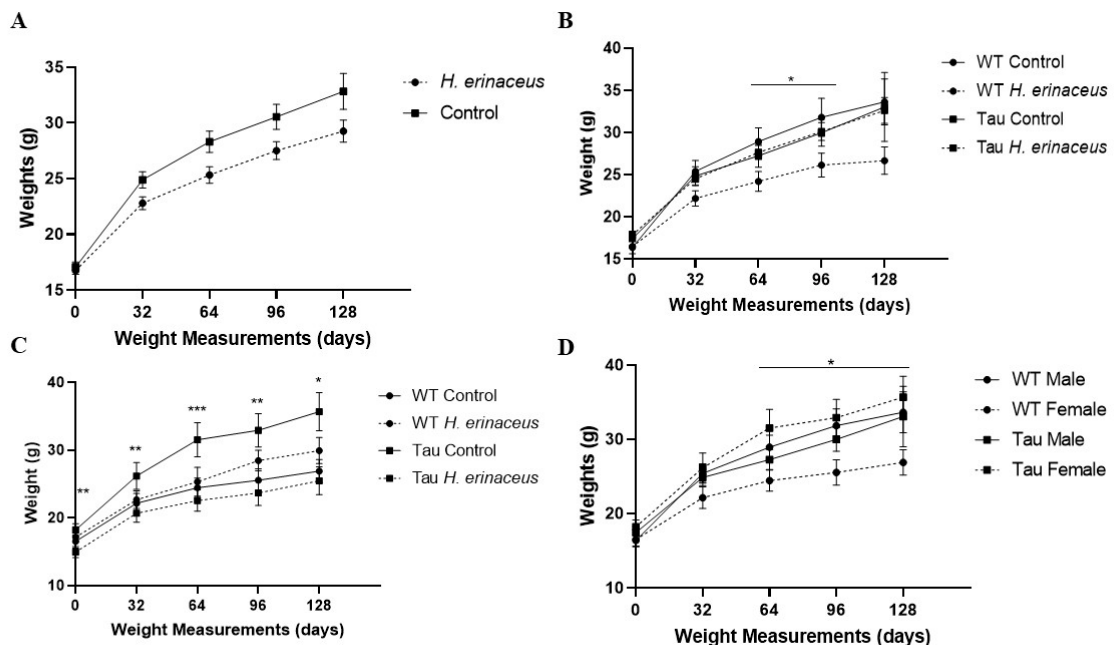
Figure 1. Weights over time. ( A ) Mice on the control diet (no H. erinaceus ) weighed significantly more than those given H. erinaceus . ( B ) Male WT mice given the control diet weighed significantly more than their H. erinaceus counterparts at 64 days and 96 days; only male mice are graphed. ( C ) Female tau mice on the control diet weighed significantly more at each weighing point than female tau mice given H. erinaceus ; only female mice are graphed. ( D ) Female tau mice weighed significantly more than female WT mice. Female tau mice weighed more than female WT mice at days 64, 96, and 128; only control diet mice are graphed. 0 = baseline; error bars represent mean ± SEM. (* p < 0.05, ** p < 0.01, *** p <